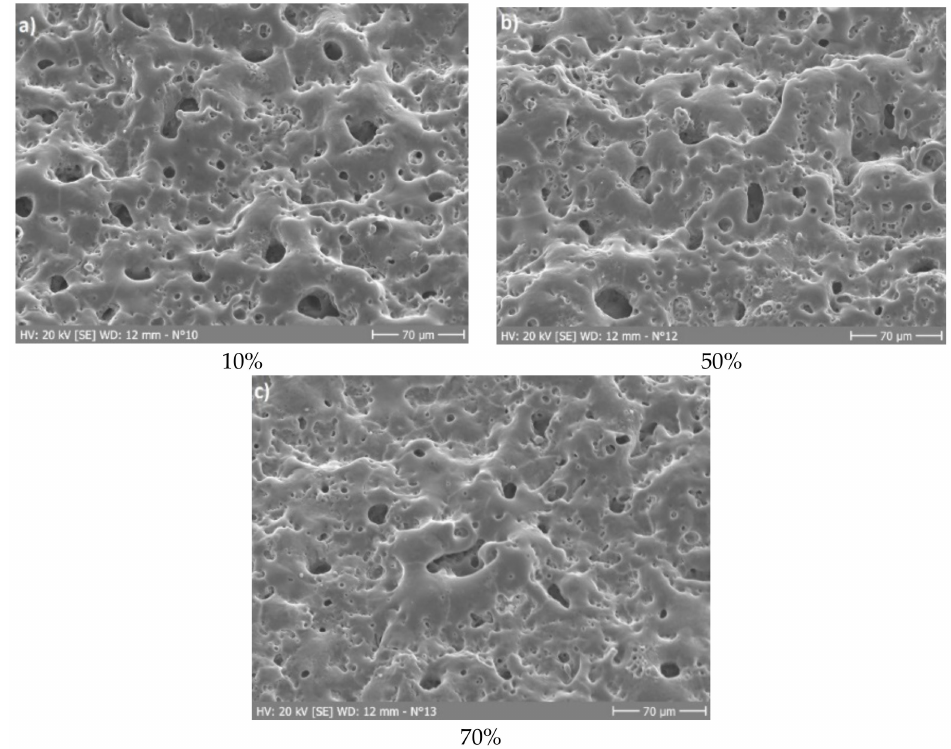
Figure 8. Surface morphology of three anodized Ti-15Mo layers obtained at different R -values (negative-to-positive current ratio): ( a ) R = 10%, ( b ) R = 50%, and ( c ) R =